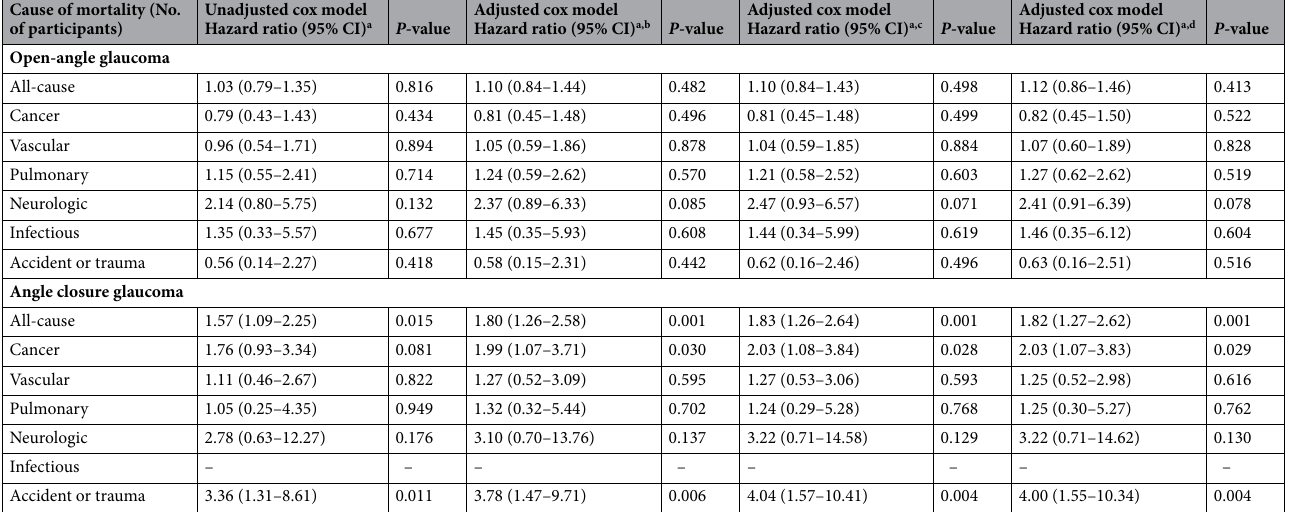
Table 5. Hazard ratios of total and cause-specific mortality in Korean elderly patients with open-angle glaucoma and angle closure glaucoma according to history of glaucoma surgery. DM diabetes mellitus. a Cox model with vitreoretinal surgery status as a time-varying covariate. b Adjusted for age and sex. c Adjusted for age, sex, income, region, Charlson Comorbidity Index (0, 1, 2, 3, 4, and ≥ 5), age-related macular degeneration, DM with ophthalmic manifestations, and cataract severity. d Adjusted for age, sex, income, region, Charlson Comorbidity Index (0, 1, 2, 3, 4, and ≥ 5), age-related macular degeneration, DM with ophthalmic manifestations, cataract severity, smoking, drinking, exercise, and body mass